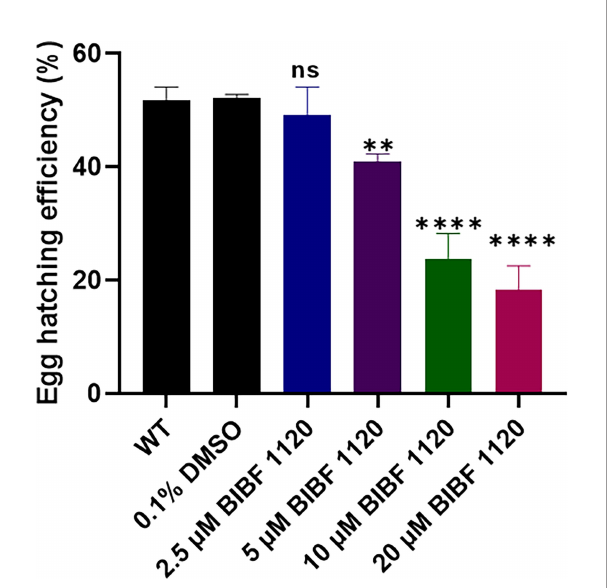
FIGURE 8 | Effects of BIBF 1120 on the hatching of S. mansoni eggs. The egg hatching ef fi ciency (%) of untreated wild type (WT) S. mansoni eggs and eggs treated with 0.1% DMSO, or 2.5 m M, 5 m M, 10 m M, and 20 m M BIBF 1120 was calculated by dividing the number of hatched eggs by the total number of eggs (hatched and unhatched eggs) X 100. (ns, not signi fi cant; ** p value ≤ 0.01, **** p value ≤ 0.0001 by One-way ANOVA).